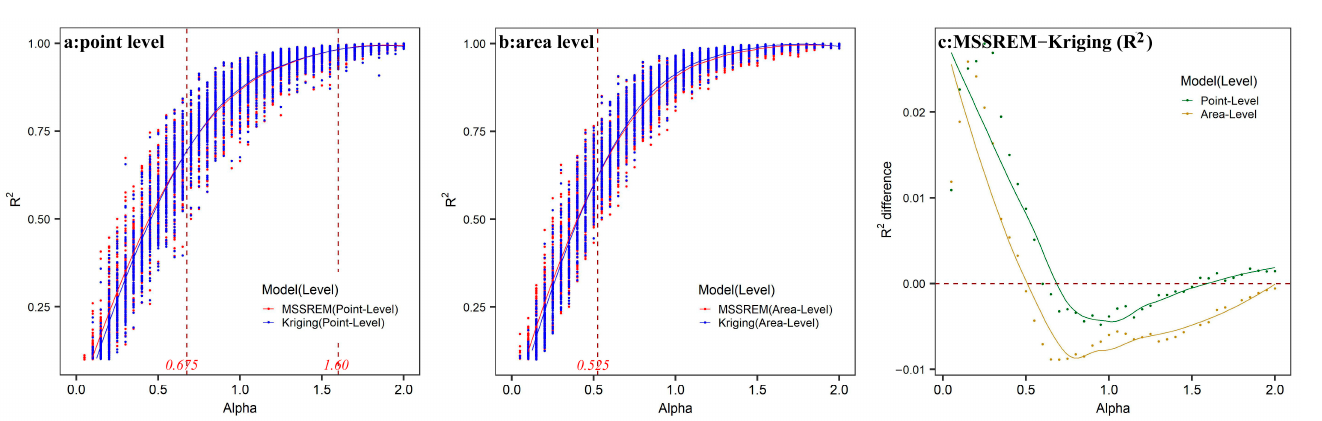
Figure 5. ( a ) Point-level modelling accuracy in MSSREM and ordinary Kriging; ( b ) area-level modelling accuracy in MSSREM and ordinary Kriging; ( c ) difference in accuracy between MSSREM and ordinary Kriging ( 𝑅 (cid:3014)(cid:3020)(cid:3020)(cid:3019)(cid:3006)(cid:3014)(cid:2870) − 𝑅 (cid:3042)(cid:3012)(cid:2870) ).